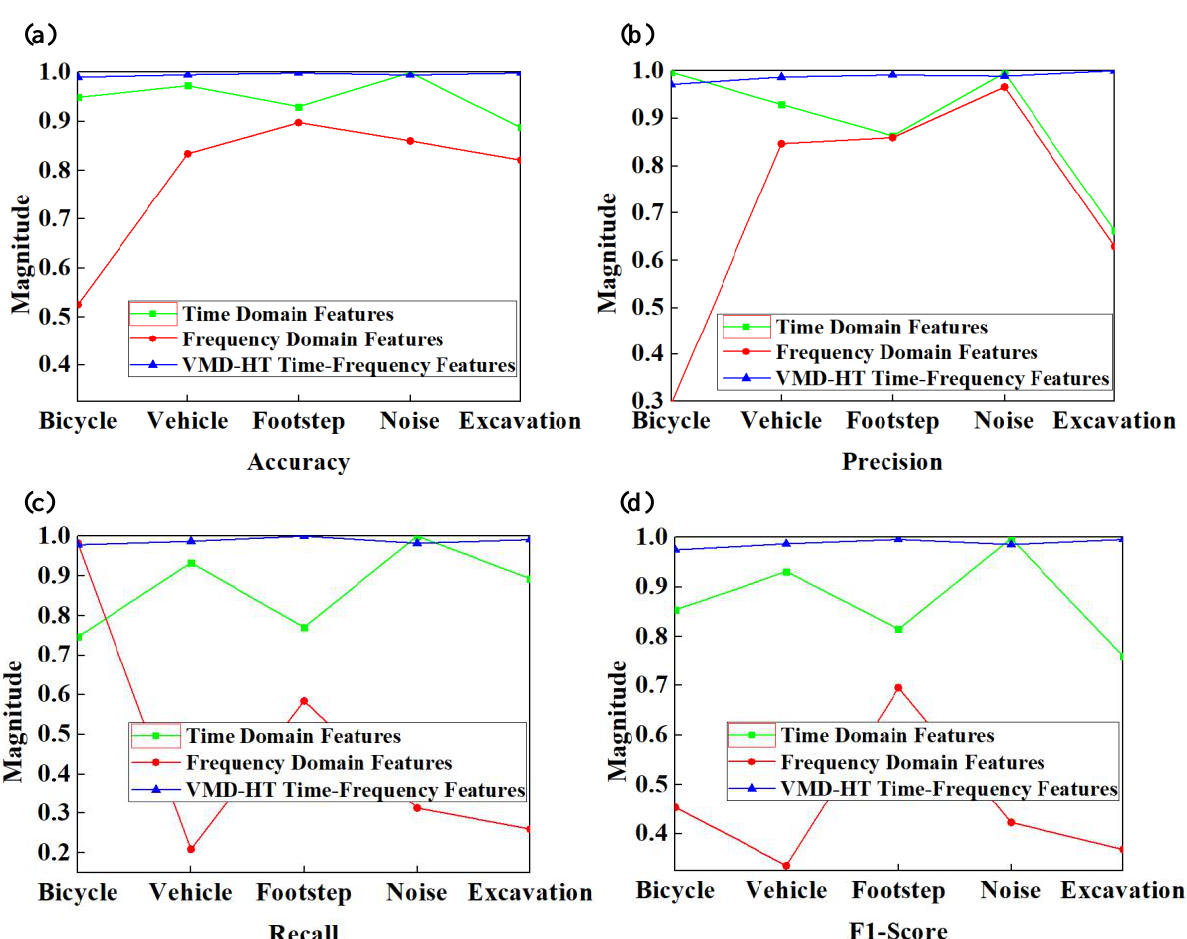
Figure 7. Evaluation indicators for classification effect of different domain features. ( a ) Accuracy for all classes. ( b ) Precision for all classes. ( c ) Recall for all classes. ( d ) F1-Score for all classes. Table 1. The improvement of proposed VMD-HT method on each class and each evaluation indi- Table 2. Comprehensive classification performance of different domain cator compared with other domain features.